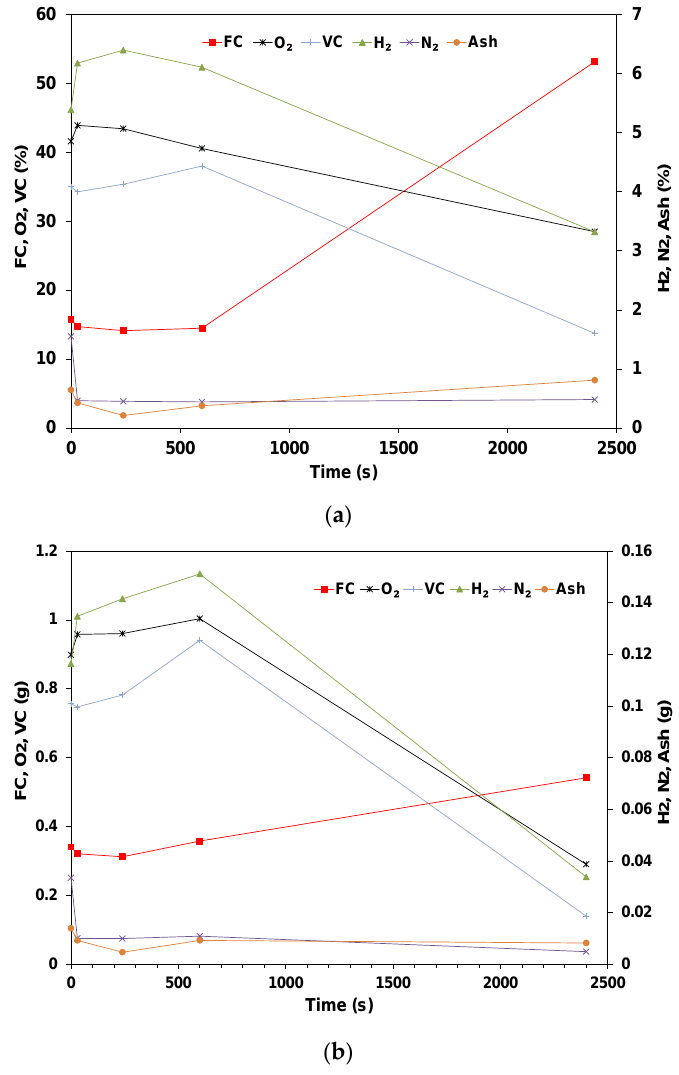
Figure 5. Elemental analysis of wood pellets at 264 °C: ( a ) in percentages and ( b ) in grams.